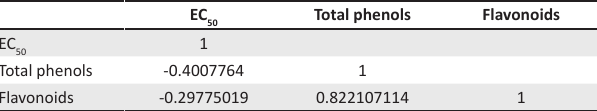
TABLE 6: Pearson’s correlation coefficient values for EC